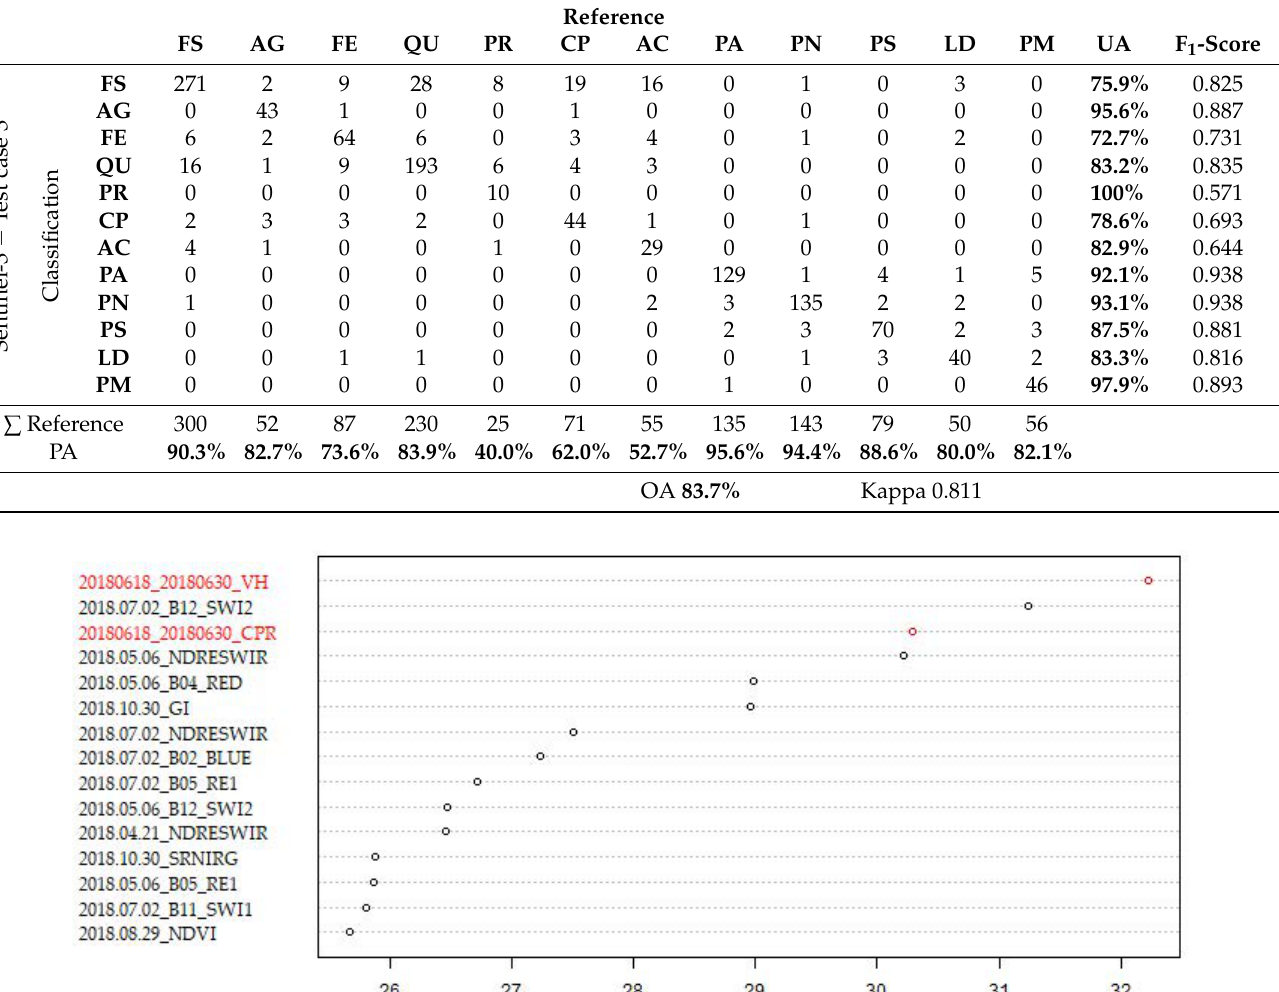
Table 8. Confusion matrix based on the out-of-bag-result of Test case 3, using Sentinel-1 data and Sentinel-2 data. UA: user’s accuracy, PA: producer’s accuracy, OA: overall accuracy; for the abbreviations of tree species names see Figure 1.